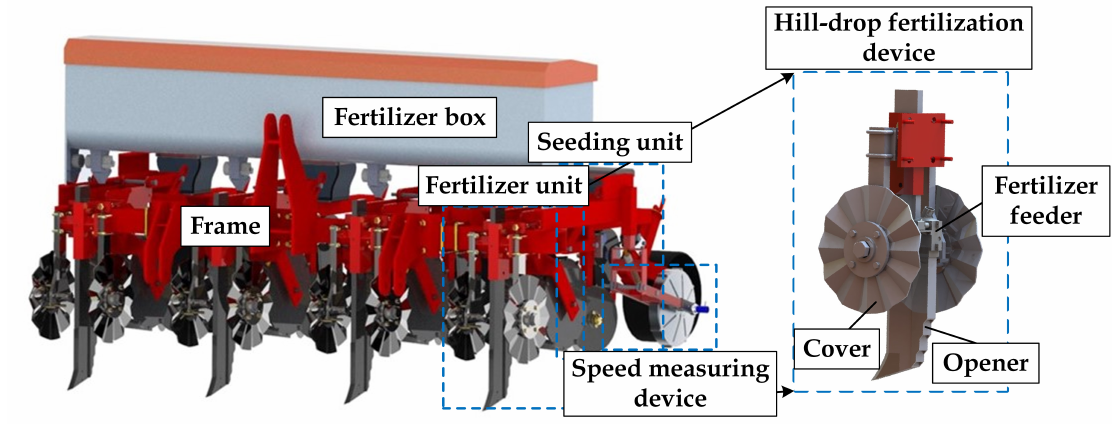
Figure 1. Corn hill-drop fertilizer